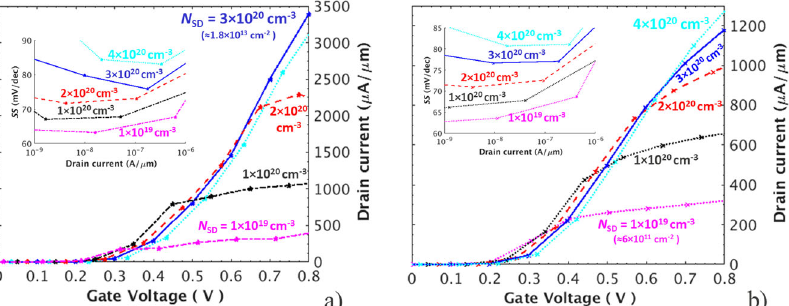
Fig. 10 Impact of source and drain doping on transfer characteristics of 2D MOSFETs. I D ( V G ) characteristics and SS ( V G ) (inset) of 2D nMOSFETs vs N SD a for HfS 2 and b for WS 2 . V D = 0.6 V. L = 5 nm. I OFF = 10 nA/ μ m. e-ph scattering is included. The trade-off between on-state (better for higher N SD values, owing to a reduction of source starvation) vs off-state (better for lower N SD values, owing to a reduction of SDT) is observed for both